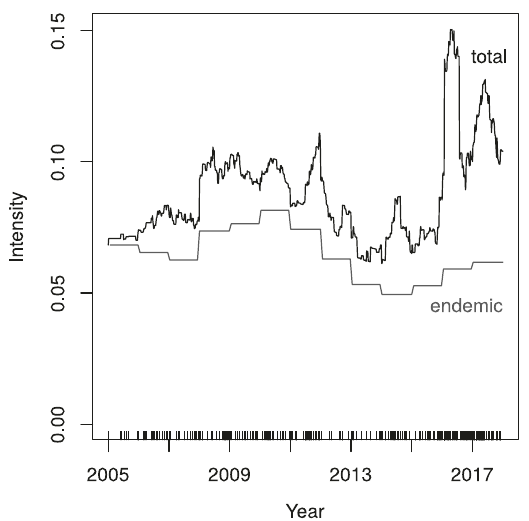
Fig. 5 The cumulative number of exposures during the last six months of the study period (red). The results of 1000 simulations are shown in grey.